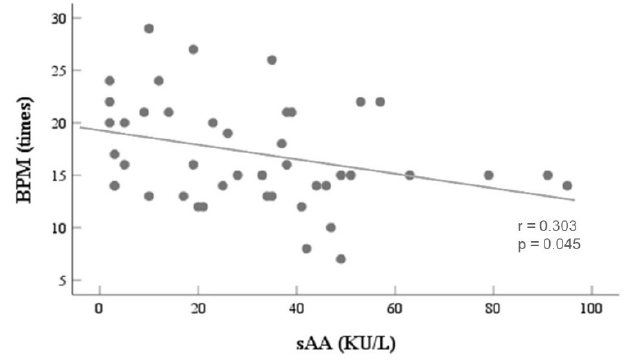
Figure 3. Scatter plots showing the Pearson correlation coefficients between BPM and sAA: The line represents the negative linear trend. The p -value and the r -value are displayed in the graph. The data from all participants are plotted for these graphs. BPMs are proportionally associated with sAA in all participants.